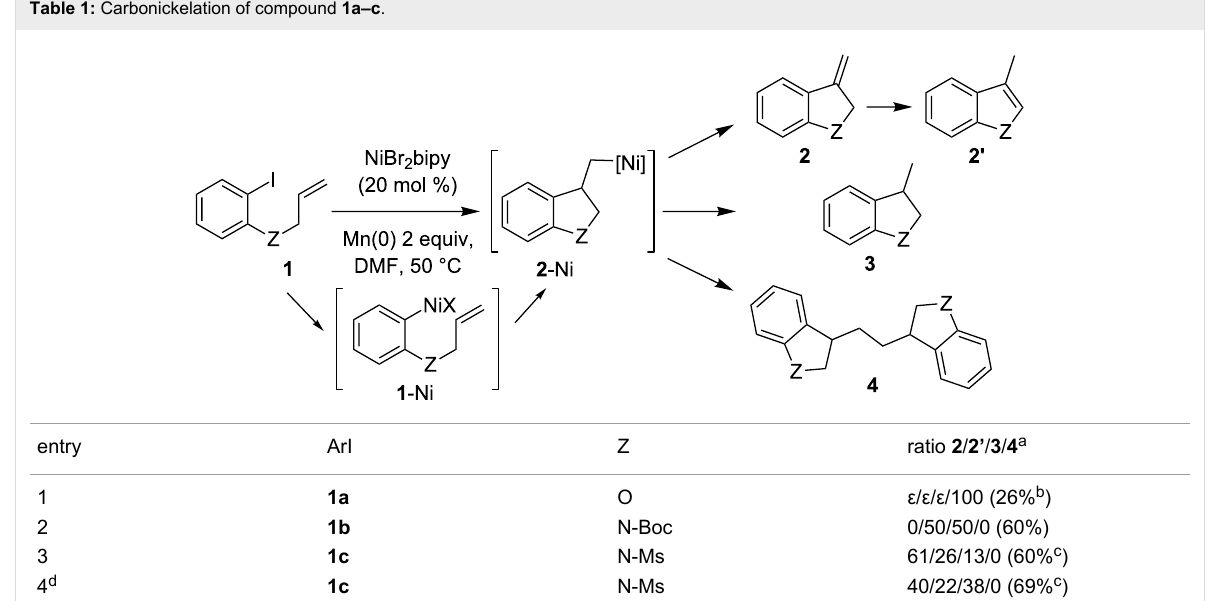
Table 1: Carbonickelation of compound 1a–c